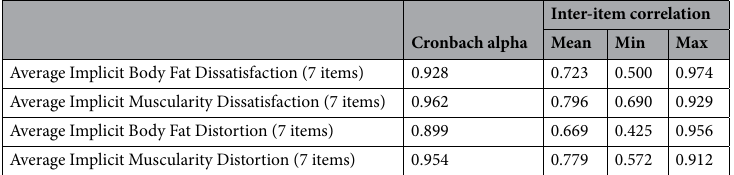
Table 4. Cronbach alpha—average implicit body fat and muscularity dissatisfaction and distortion.